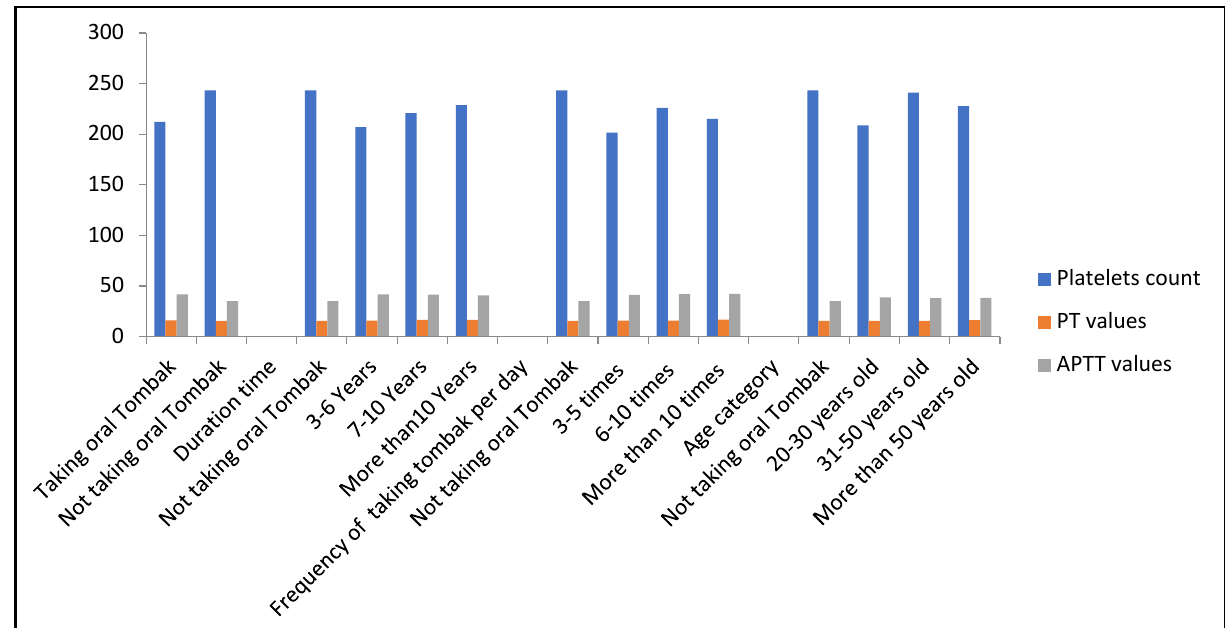
Figure 1. The effects of taking oral Tombak on PT, APTT, and PLT values among the study population.